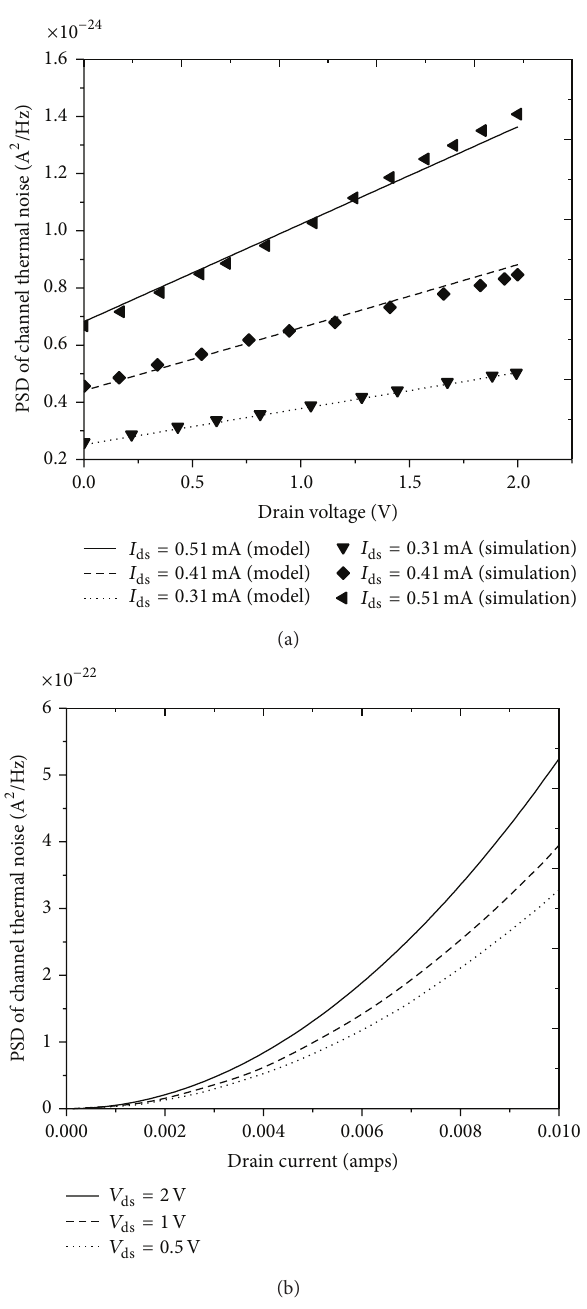
Figure 2: (a) Power spectral density of channel thermal noise versus drain source voltage of the SNWMOSFET. (b) Power spectral density of channel thermal noise versus drain current of the